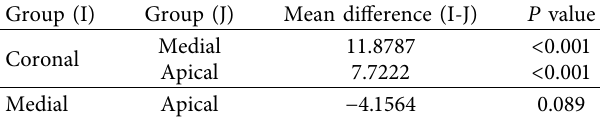
Table 5: Pairwise comparisons of the root areas regarding the percentage of sealer by the Games–Howell